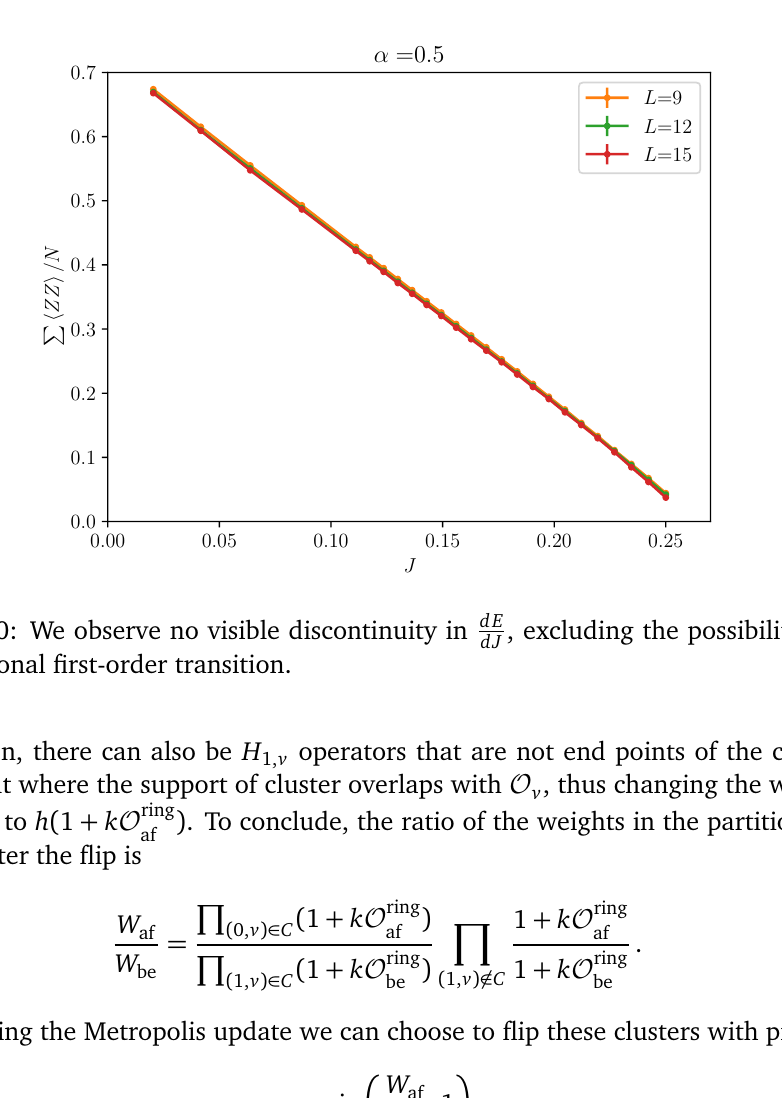
, excluding the possibility of a dJ